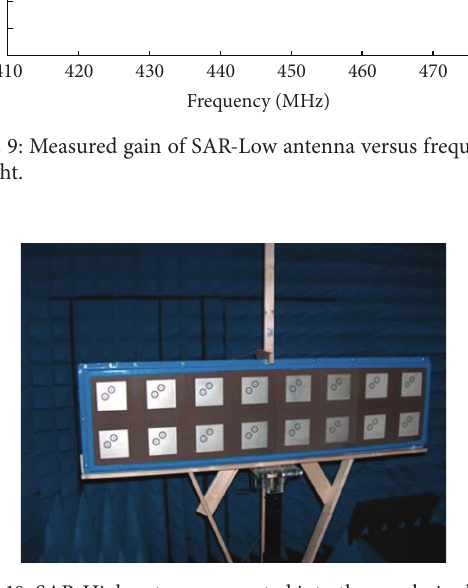
Figure 10: SAR-High antenna mounted into the anechoic chamber at University of